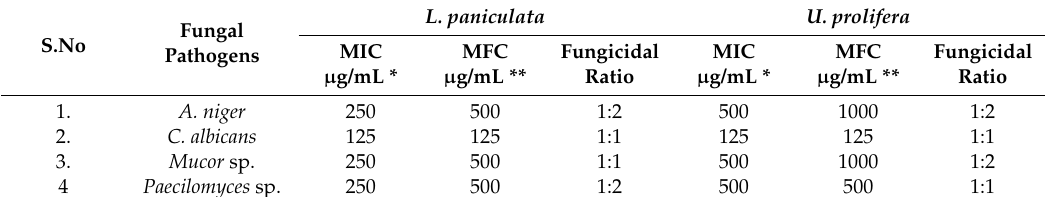
Table 2. Minimum inhibitory concentration (MIC) and minimum fungicidal concentration (MFC) of ethanolic fractions of L. paniculata and U. prolifera with fungicidal ratio.